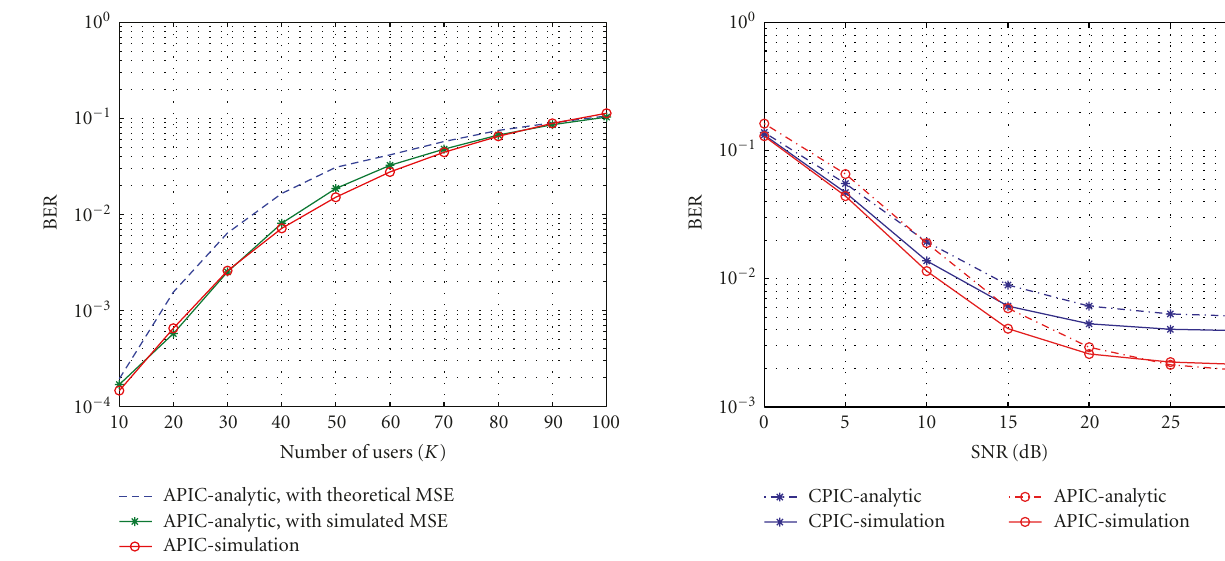
Figure 4: Theoretical and simulation results of the one-stage APIC receiver, N = 32, SNR = 20dB.